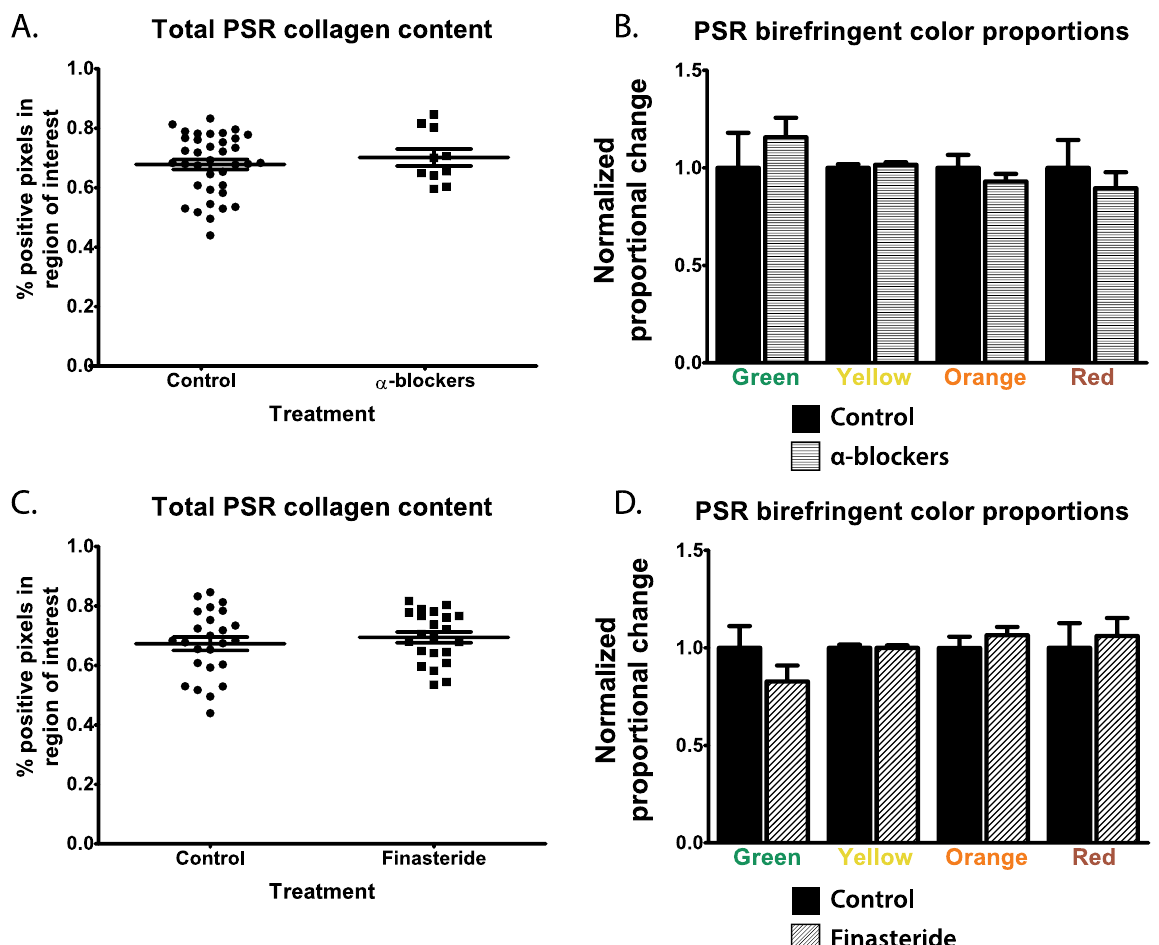
Figure 4. Association of Picrosirius red fibrillar collagen content in glandular BPH specimens with pre-TURP treatment with a - blockers and finasteride. A total of 47 patients undergoing transurethral resection of the prostate (TURP) for treatment of BPH at the University of Wisconsin Hospital were randomly selected for inclusion in this study. TURP samples were stained for Picrosirius red, and 3 representative acinar lobules were imaged under polarized light. Staining was quantified as total collagen content and proportion of colors within birefringent tissue, and triplicate images for each patient were averaged. Treatment with a -blockers (n=37 patients) had no significant effect on total collagen content in glandular BPH nodules (p=0.52; A ). No changes were observed in the proportion of green (normalized mean=1.157 6 0.010 vs. 1.000 6 0.180; p=0.47), yellow (1.016 6 0.013 vs. 1.000 6 0.019; p=0.55), orange (0.930 6 0.039 vs. 1.000 6 0.067; p=0.40), or red (0.896 6 0.082 vs. 1.000 6 0.143; p=0.55) birefringent tissue ( B ). Similarly, treatment with finasteride (n=22 patients) had no effect on total collagen content within the tissues (p=0.47; C ). No significant changes in the proportion of green (0.828 6 0.082 vs. 1.000 6 0.112; p=0.23), yellow (1.000 6 0.013 vs. 1.000 6 0.017; p=1.00), orange (1.065 6 0.042 vs. 1.000 6 0.058; p=0.38), or red (1.061 6 0.092 vs. 1.000 6 0.127; p=0.71) collagen bundles were observed ( D